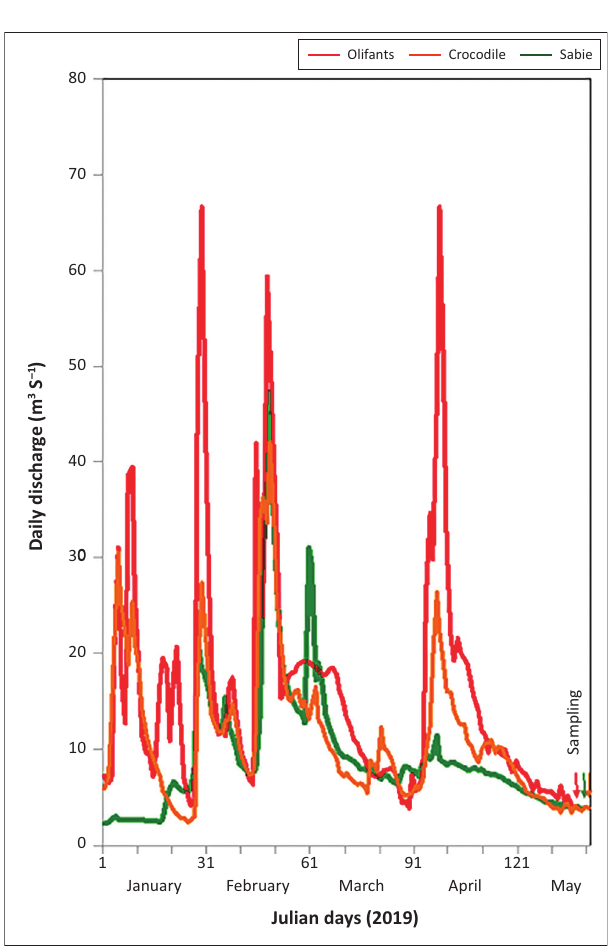
FIGURE 1-A1: Mean daily discharge of Olifants, Sabie and Crocodile rivers before sampling over the period January–May 2019.